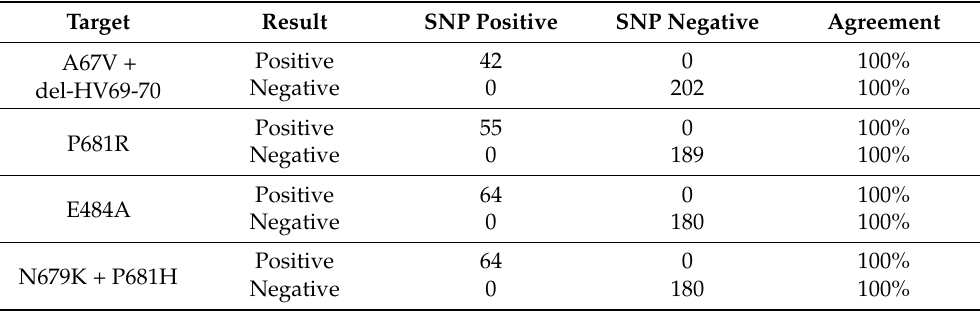
Table 4. SCOV2_OMIC_VOC-UCT results for the clinical sample set. Each target/channel is analyzed